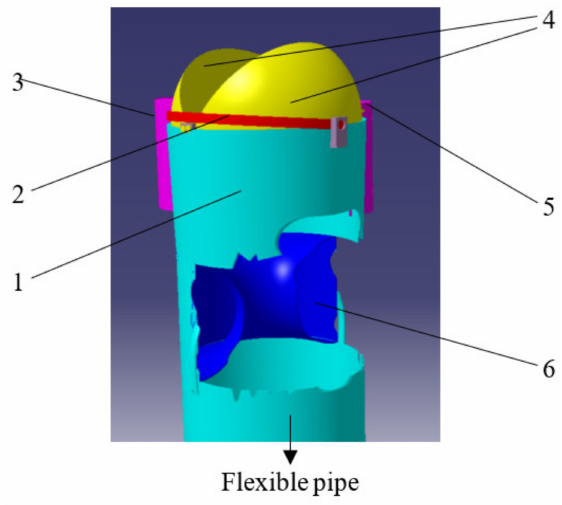
Figure 13. Structure of the new end-effector for a citrus picking robot meeting the demands of the spherical fruit and clamp damage reduction: 1, tube; 2, swing knife; 3, motor; 4, spherical finger; 5, motor; 6,